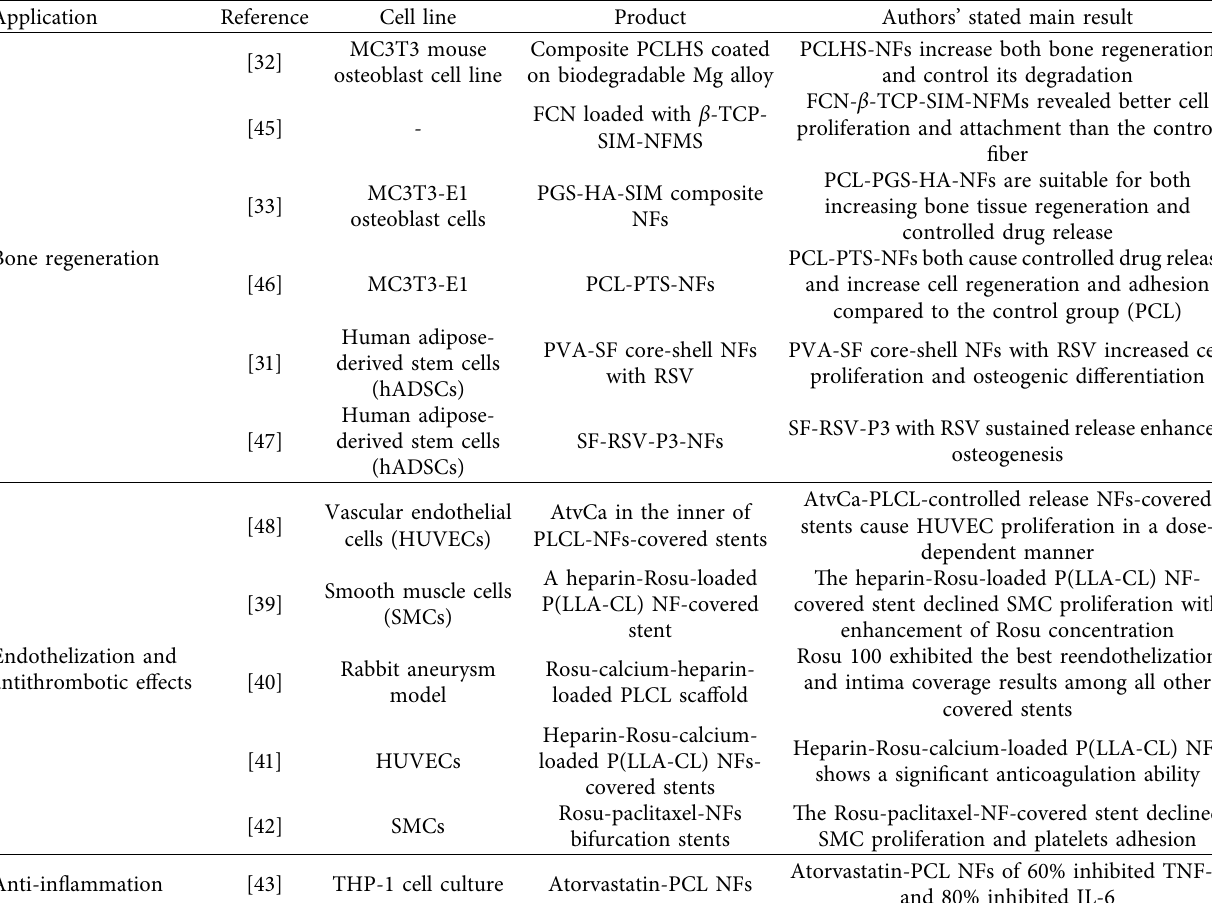
Table 1: Summary of in vitro applications of statins in various